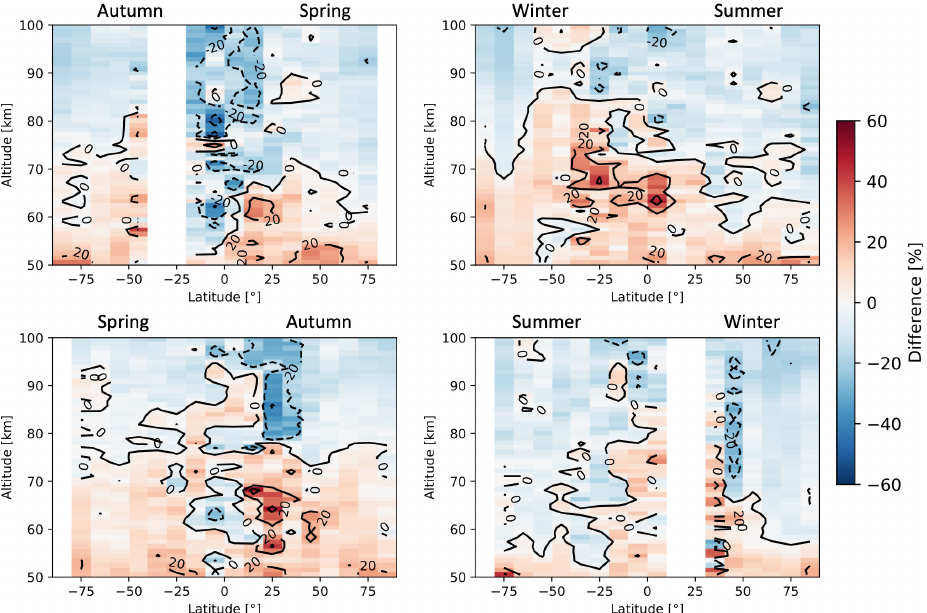
Figure A4. Seasonal zonal means of SMR–ACE relative differences averaged over the whole time between February 2004 and March 2019. The seasons are intended as the time between the solstice and the